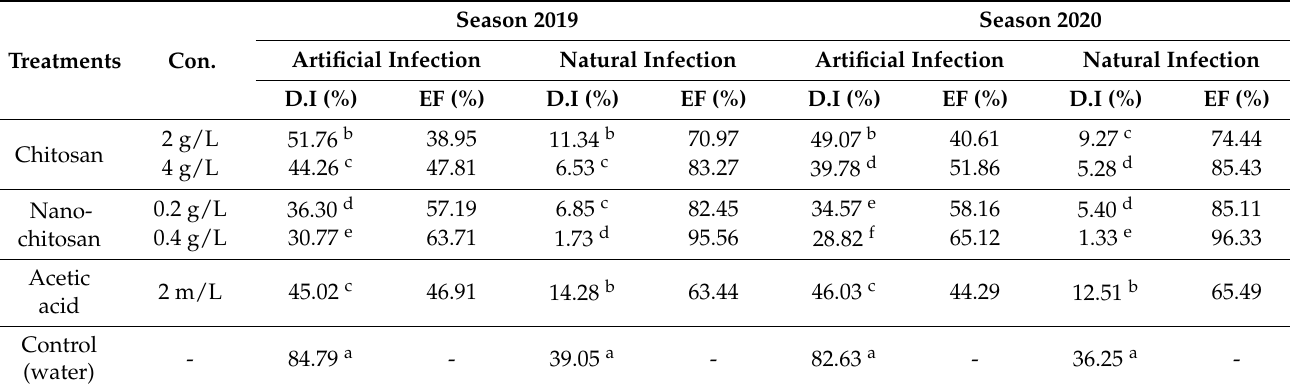
Table 3. Effect of pre-harvest sprays of chitosan and its nanoform against artificial and natural infection of blue mold of Anna apples after 45 days of cold storage at 4 ± 1 ◦ C during seasons 2019 and 2020.